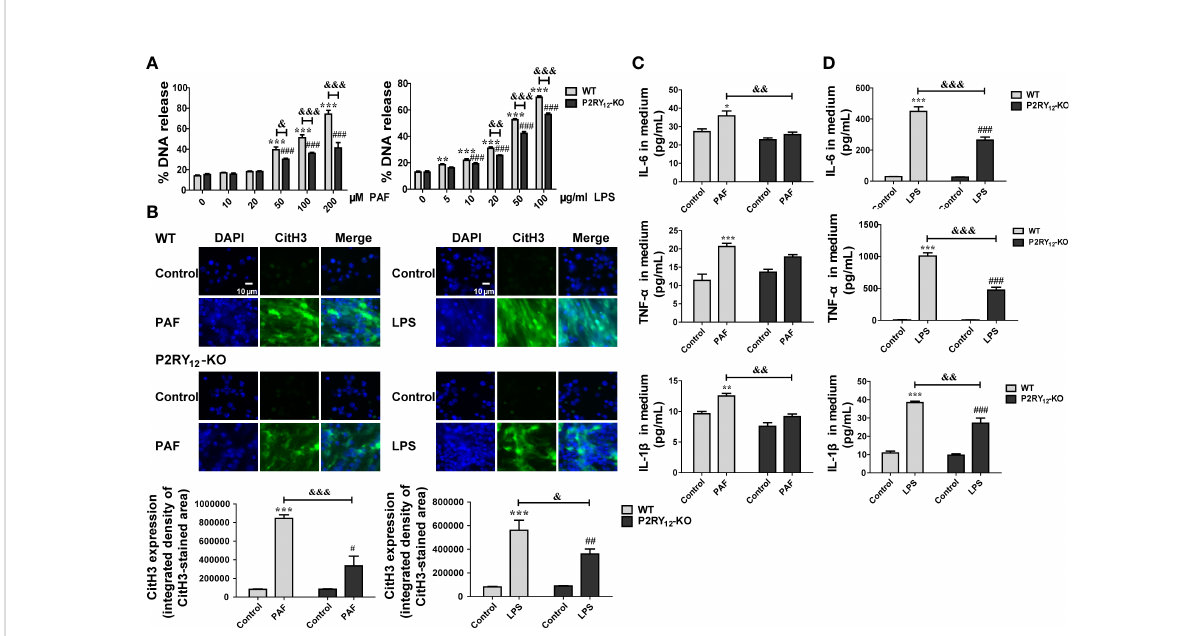
FIGURE 1 Effects of P2RY 12 on PAF and LPS-induced NET release and in fl ammatory responses. (A) Different concentrations of PAF or LPS induced the release of cfDNA from WT or P2RY 12 -KO neutrophils (n = 4). (B) Immuno fl uorescent staining and statistical analysis of CitH3 and DAPI staining of WT or P2RY 12 -KO neutrophils induced by PAF and LPS, respectively (n = 4). (C, D) Release of IL-6, IL-1 b , and TNF- a in medium of WT or P2RY 12 -KO neutrophils induced by PAF and LPS, respectively (n = 4). All the data are shown as the mean ± SEM. * P < 0.05, ** P < 0.01, *** P < 0.001 vs. WT control; ### P < 0.001 vs. P2RY 12 -KO Control; & P < 0.05, && P < 0.01, &&& P < 0.001, WT vs. P2RY 12 -KO. #P < 0.05, ##P < 0.01.